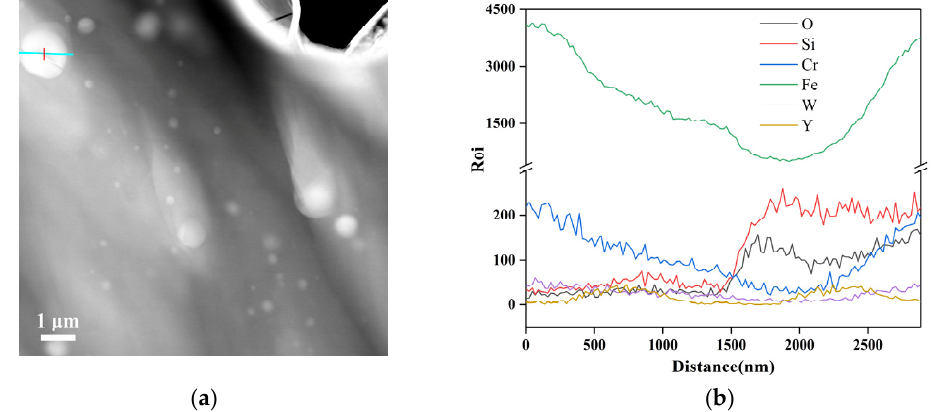
Figure 7. ( a ) High-angle circular dark field (HAADF) image of 1280-S3 ODS steels. ( b ) Line scan component analysis of 1280-S3 ODS steels.